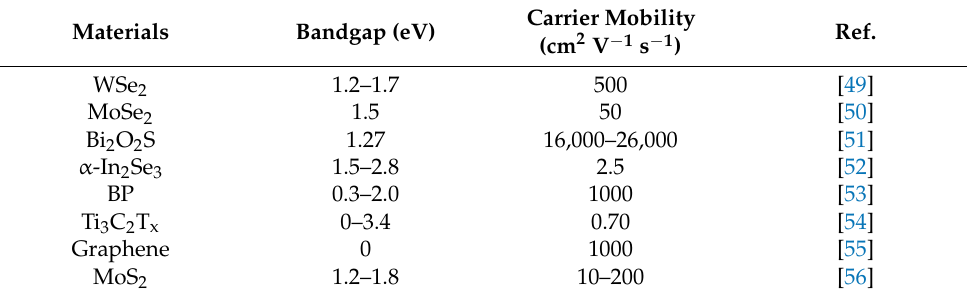
Table 1. The physical parameters of a few novel 2D materials applied in OSCs. Materials Bandgap